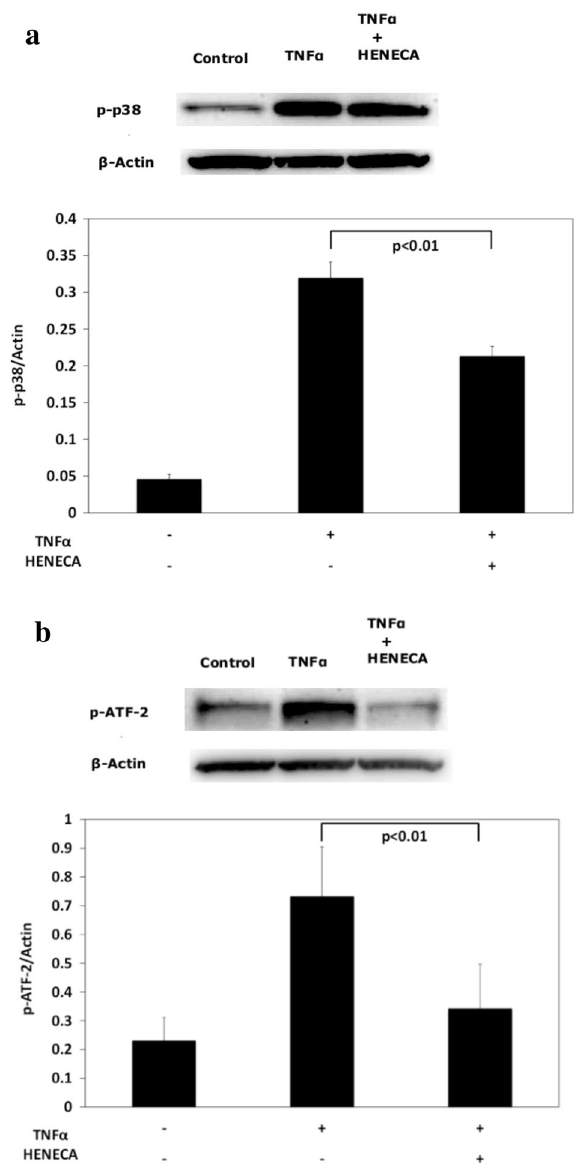
Figure 6. Stimulation of A 2A AdoRs reverses the TNFα-mediated activation of p38 MAPK signaling in MH7A cells. Activation of A 2A receptor signaling suppressed TNFα-induced activation of p38 MAPK and ATF-2. Cells were incubated for 10 min ( a ) or 1 h ( b ) in TNFα (1 ng/ml) with or without HENECA (1 μM). Expression levels of p-p38 and p-ATF-2 were estimated by western blotting and densitometry. HENECA suppressed TNFα- induced phosphorylation (activation) of p38 MAPK ( a ) and ATF-2 ( b ). ß-actin served as the gel loading control. Original blots/gels are presented in Supplementary Figs. 3, 4, 5, 6. Experiments were repeated three times and data are presented as the mean ± SD. p < 0.01 versus TNFα